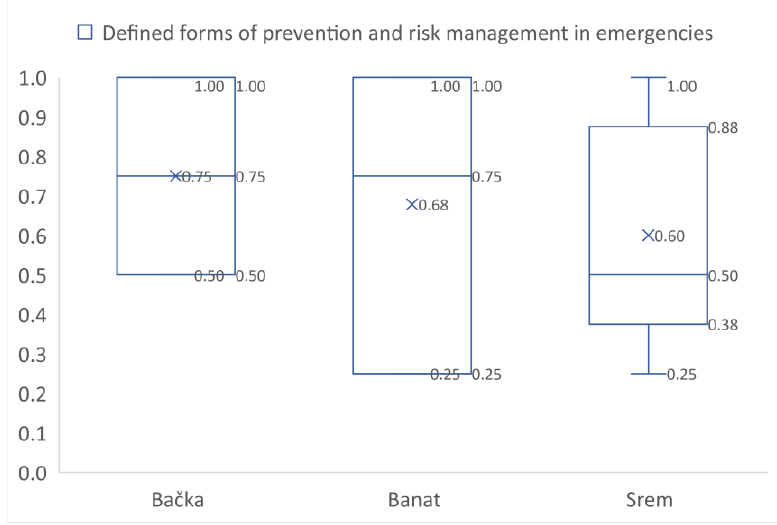
Figure 4: Defined Forms of Prevention and Management of Highest Risks Emergencies (Source: Authors’